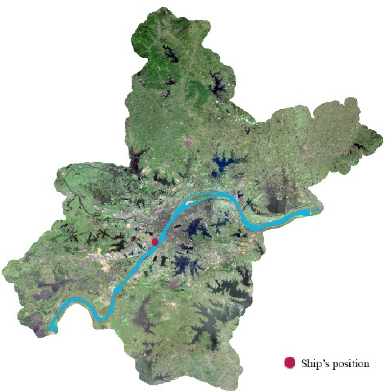
Figure 1. Satellite image of Wuhan City (source of base map: Resource Satellite 3).